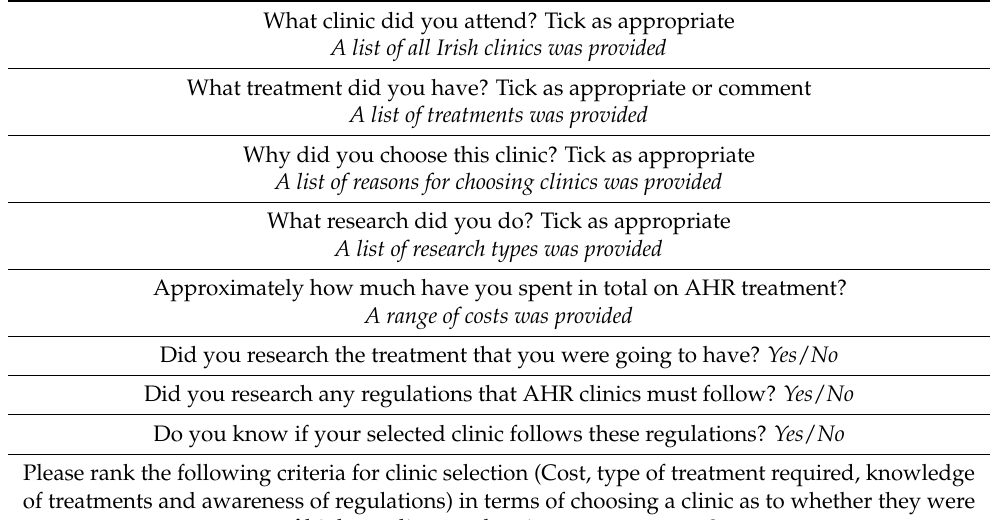
Table 2. Survey Questions